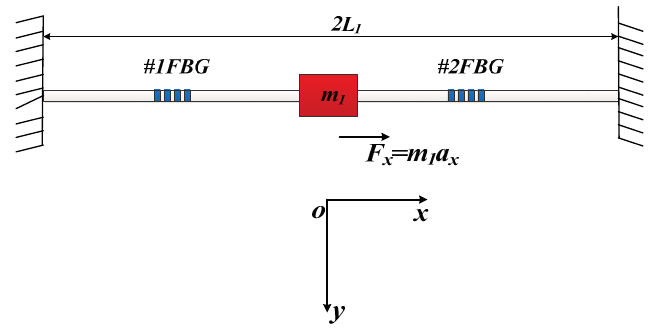
Figure 2. Vibration model of optical fiber in axial